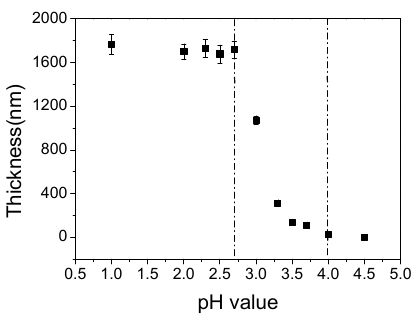
Figure 5. Thickness of (PEOX/PAA) 20 as a function of pH value. (PEOX, M w 50,000, 1 mg/mL; PAA, M w 450,000, 1 mg/mL; assembling time, 4 min; rinsing time, 1 min; and room temperature).